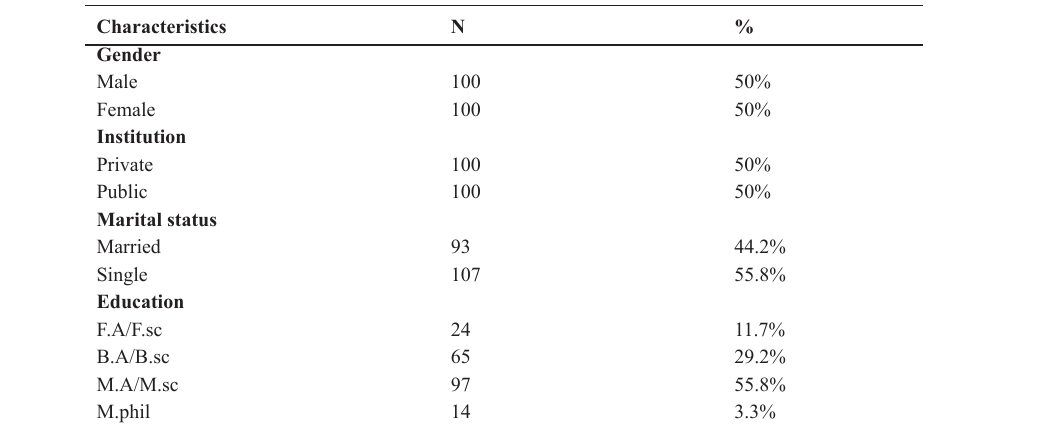
Table 1 The Frequency and Percentage of Participant’s Demographics